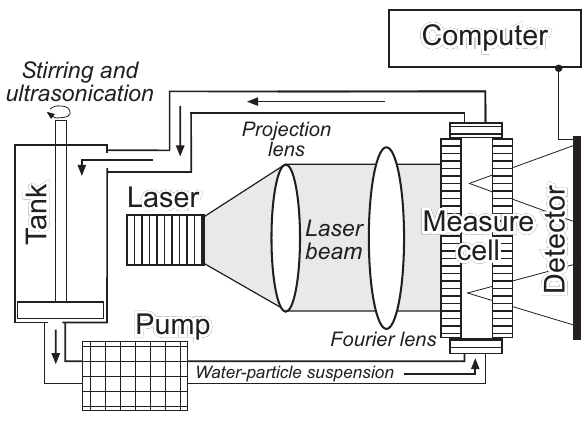
Fig. 1. Schematic cartoon showing the main components of a laser diffraction particle size analyser. See text for